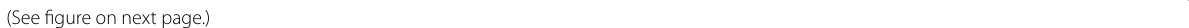
Fig. 10 Crocodylia from the Iquitos assemblage. A1 – K Partial right skull roof ( A1 – A3 : PIMUZ A/III 4567), proximal part of a right quadrate ( B1 – B2 : PIMUZ A/III 4587), central part of a right angular ( C1 – C2 : PIMUZ A/III 4569), posterocentral portion of a dentary ( D1 – D2 : PIMUZ A/III 4569), anterior part of a left surangular ( E1 – E2 : PIMUZ A/III 4587), partially preserved left ilium ( F1 – F2 : PIMUZ A/III 4568), partial dorsal osteoderm ( G1 – G2 : PIMUZ A/III 4587), and teeth ( H1 – H2 : PIMUZ A/III 4579; I : PIMUZ A/III 4573; J – K : PIMUZ A/III 4584) of † Purussaurus sp. L1 – L8 Juvenile gryposuchine Gavialidae (PIMUZ A/III 4575). L1 – L3 Mid‑region of a right dentary. L4 – L5 Part of the maxilla. L6 – L8 Posterior part of an articular. M1 – N3 Globular teeth ( M1 – M3 : PIMUZ A/III 4591; N1 – N3 : PIMUZ A/III 4592) tentatively identified to † Gnatusuchus pebasensis . Abbreviations: Mc (Meckel’s canal). Views: anterodorsal ( E2 ), dorsal ( A1 , G1 , L2 , L6 ), cross sectional ( G2 ), labial ( H1 , N2 ), lingual ( I – J , M2 ), lateral ( E1 , H2 , L8 , M3 , N3 ), left lateral ( B1 , C1 , D1 , F1 , L5 ), right lateral ( A3 , L3 ), medial ( B2 , C2 , D2 , F2 , L7 ), occlusal ( M1 , N1 ), ventral ( A2 , L1 , L4 ), and indet. (